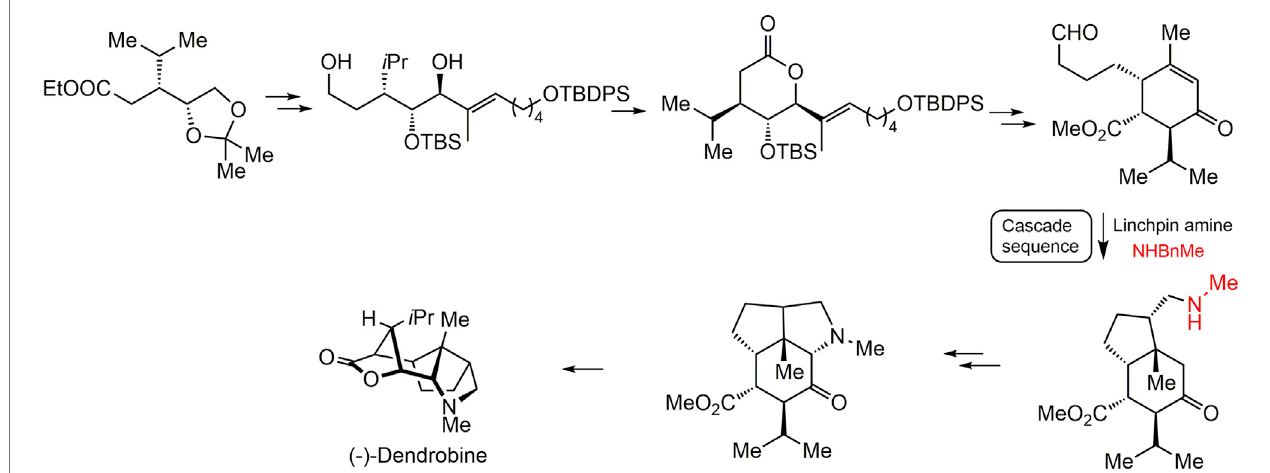
FIGURE 7 | The total chemical synthesis strategy of (-)-dendrobine proposed by Kries and Carreira (2012).